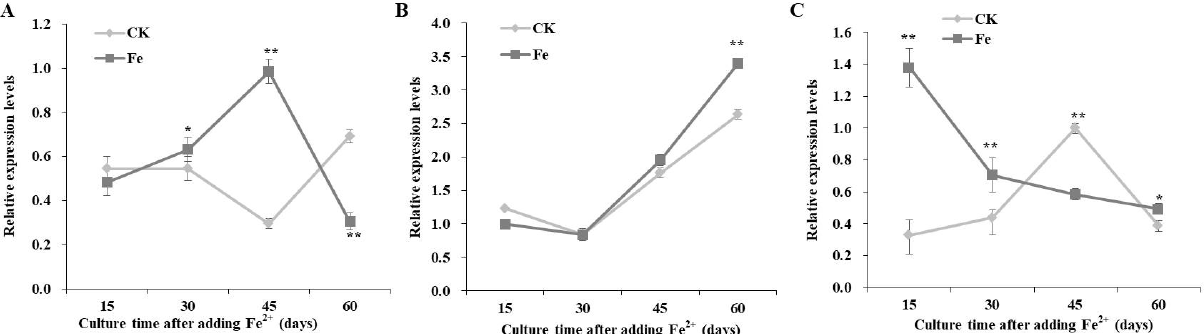
Figure 4. Transcriptional expression levels of pgi ( A ), pgm ( B ), and ugp ( C ) in Lentinula edodes 808 (ACCC 52357) during 60 days of static cultures after Fe 2+ addition. CK: control without Fe 2+ addition; Fe: as FeCl 2 , 200 mg/L of Fe 2+ added after 7 days of shaking at 150 rpm and 3 days of static culture. Data are the means of experiments in triplicate ± SD. Asterisks indicate a significant statistical difference at p < 0.01 (**) and p < 0.05 (*), according to the LSD